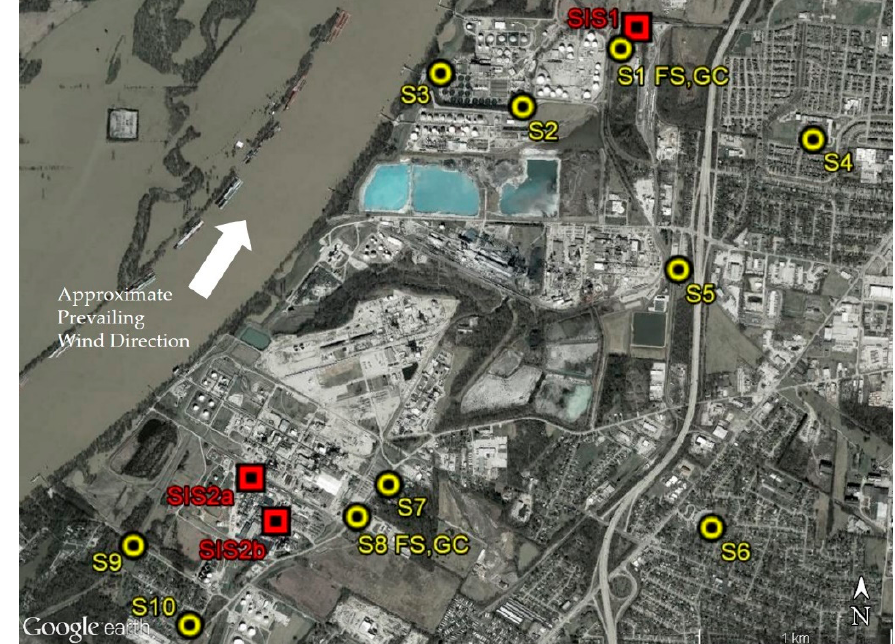
Figure 1. Measurement sites for the first year of operation of the Rubbertown NGEM Demonstration Project. Yellow circles indicate primary measurement sites. Red squares indicate approximate locations of the example short-term SIS emissions events.